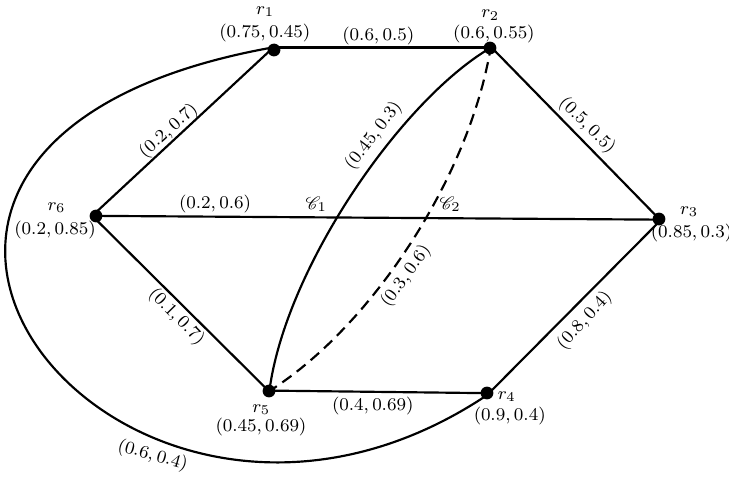
Figure 5. Pythagorean fuzzy planar Figure 3.2: Pythagorean fuzzy planar graph